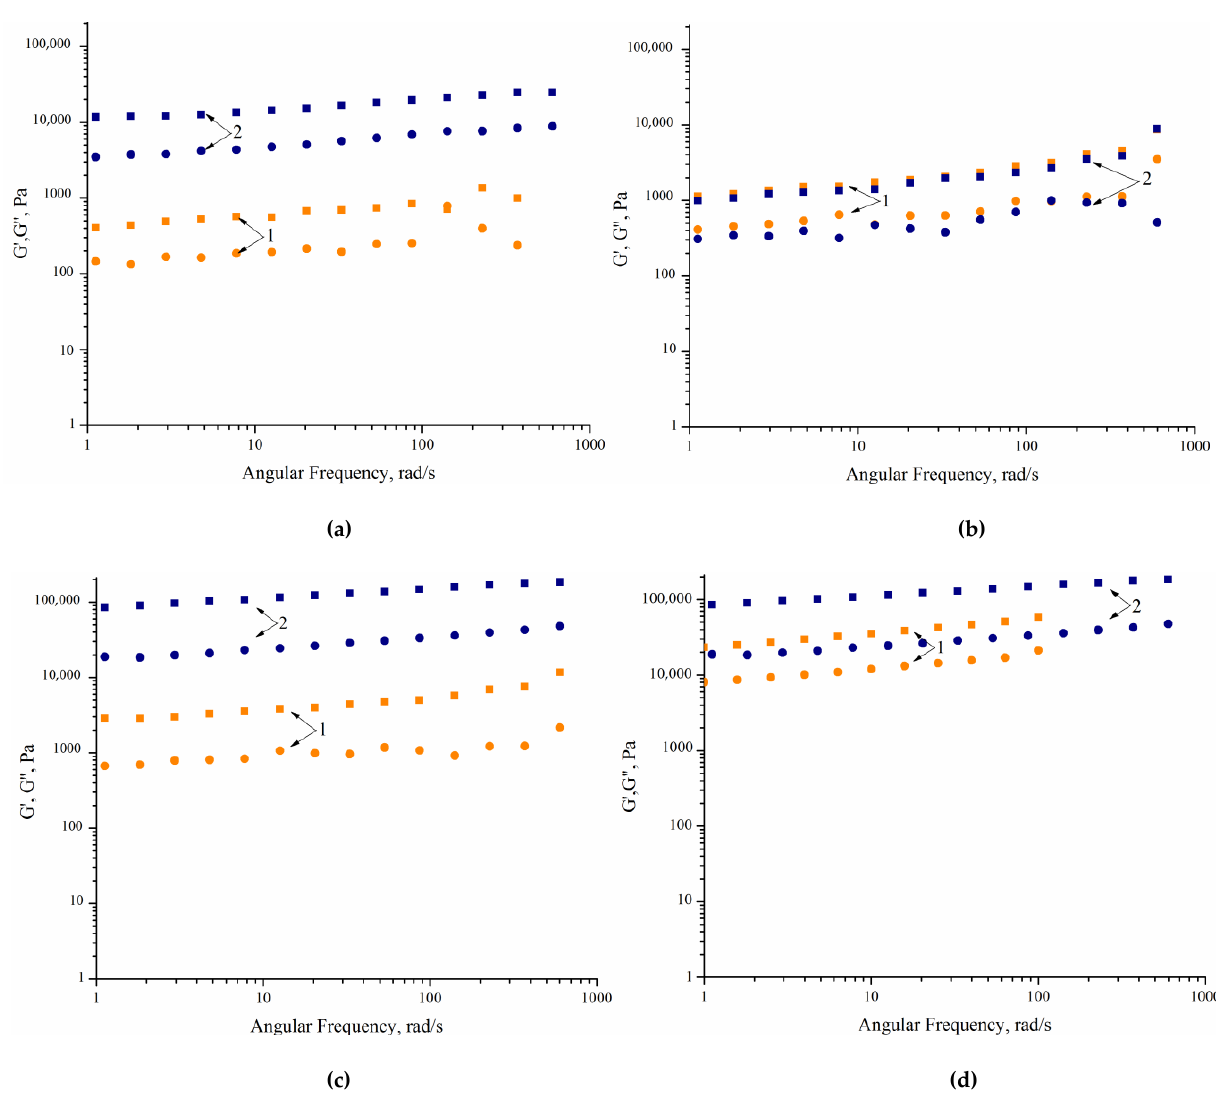
Figure 7. Frequency correlation of dynamic storage modulus G (cid:48) (solid squares) and loss modulus G” (solid circles) for WPU dispersions (0.01% strain): ( a ) 1—sample 1.1, 2—sample 2.1; ( b ) 1—sample 1.4, 2—sample 2.4; ( c ) 1—sample 1.7, 2—sample 2.7; ( d ) 1—1.7, 2—sample